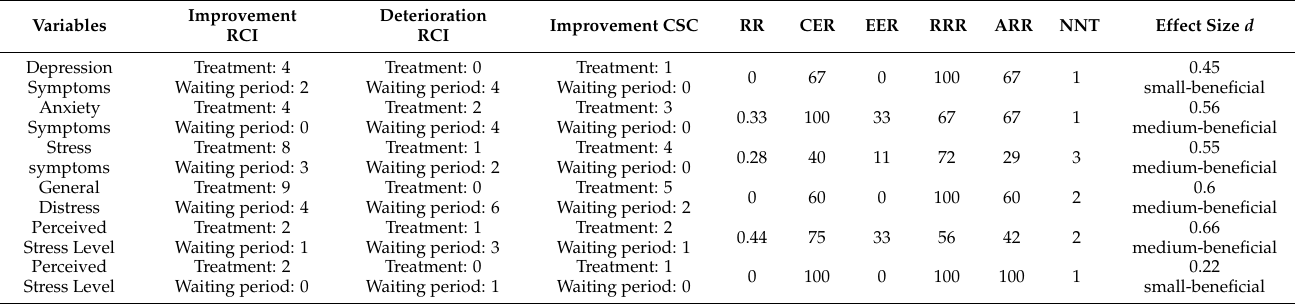
Figure 4. Daily changes in the subjective experience (refreshed feelings, SRSI3-Rest/Refresh; ener- gised feelings; SRSI3-Energised, relaxation SRSI3-Physical relaxation; feelings of peace, SRSI3-At ease/peace; feelings of joy, SRSI3-Joy; mental quiet, SRSI3-Mental quiet; mental awareness, SRSI3- Aware; somatic stress, SRSI3-Somatic stress; emotional stress, SRSI3- Emotional stress; cognitive stress, SRSI3-Cognitive stress; anxiety level, State–Trait Anxiety Inventory-State—STAI-S; discomfort, Subjective Units of Distress Scale SUDS). State measures collected each day during the waiting week (7 days before the start of the intervention) and during the intervention phase, after each treatment module. Mean and 95% CI are depicted in the graphs. Table 4. Clinical change analyses for the primary outcome measures. RCI indicates the number of participants who improved (improvement RCI) or worsened (deterioration RCI) from the waiting period to the treatment period for the relevant scales. CSC shows the number of participants that reached a clinical change in the selected scales. RCI is used to calculate risk and efficacy measures. RCI: reliable change index; CSC: clinically significant change; RR: relative risk; CER: control event rate; EER: experimental event rate; RRR: relative risk reduction; AAR: absolute risk reduction; NNT: number needed to treat. Measures from CER to NNT are expressed in